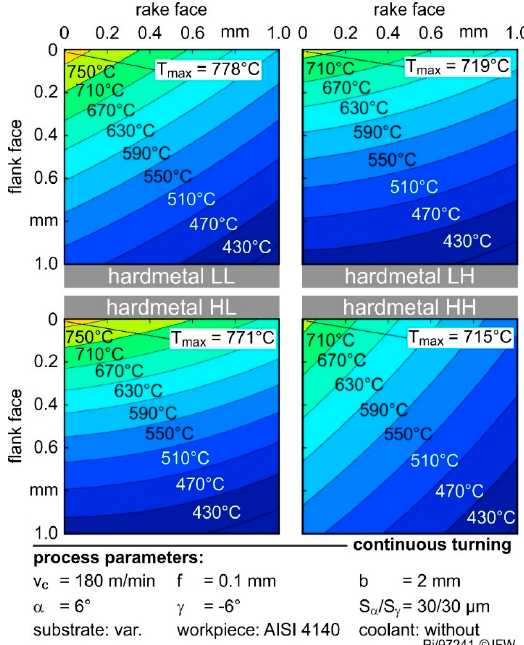
Figure 8. Comparison of the temperature distribution of the used cemented carbides.